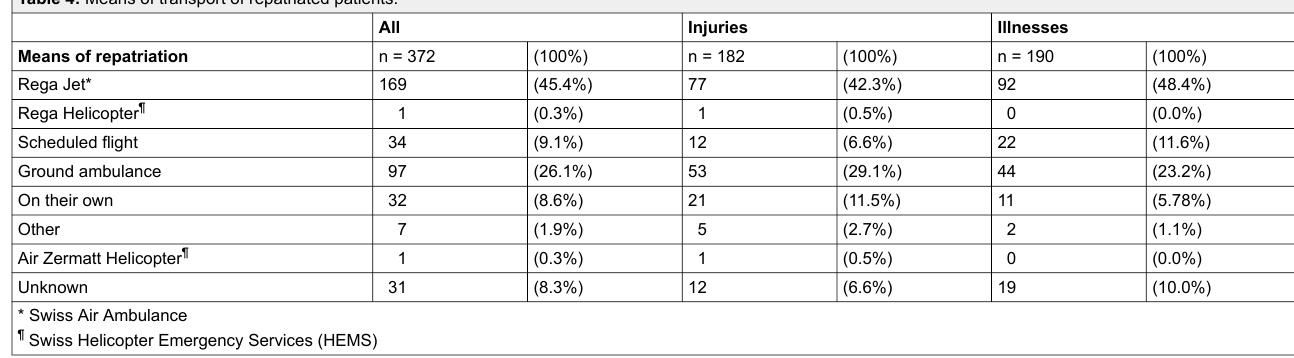
Table 5 : Diagnostic groups of patients with illnesses. Diagnostic